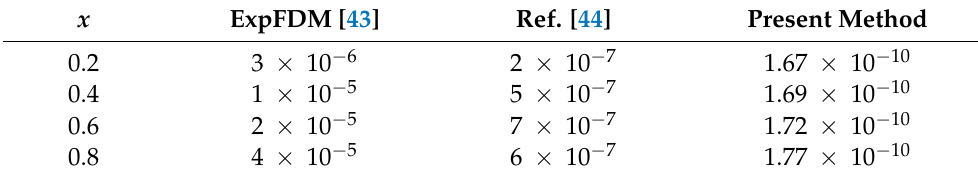
Table 1. The absolute errors of u ( x , t ) at t = 0.04, τ = 5.00 e − 3, and µ = 0.5.